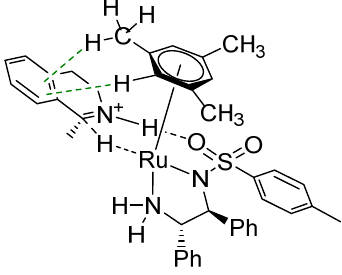
Figure 5. Transition state of hydrogenation of 1-methyl-3,4-DHIQ with [RuH( η 6 - mesitylene)TsDPEN] featuring double CH/ π interaction.